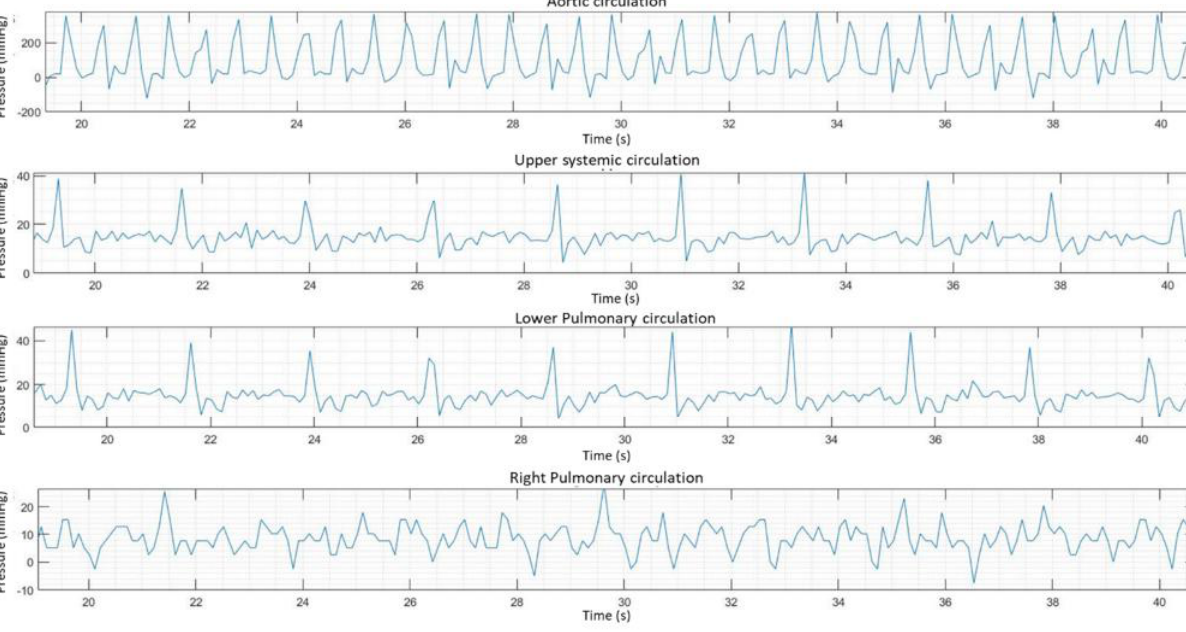
Figure 14 . Unfiltered pressure waveform for 3 mm IJS with 5 degree anastomosis angle experiment.